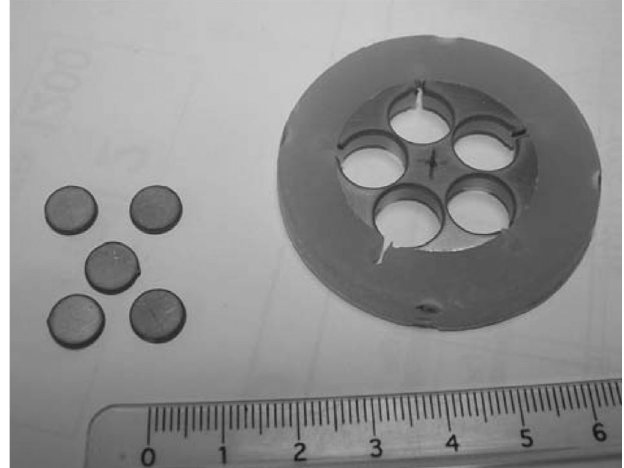
FIG. 7. Image of the five SC samples (diameter 8 mm) cut by water-jet from Nb sheet (diameter 30